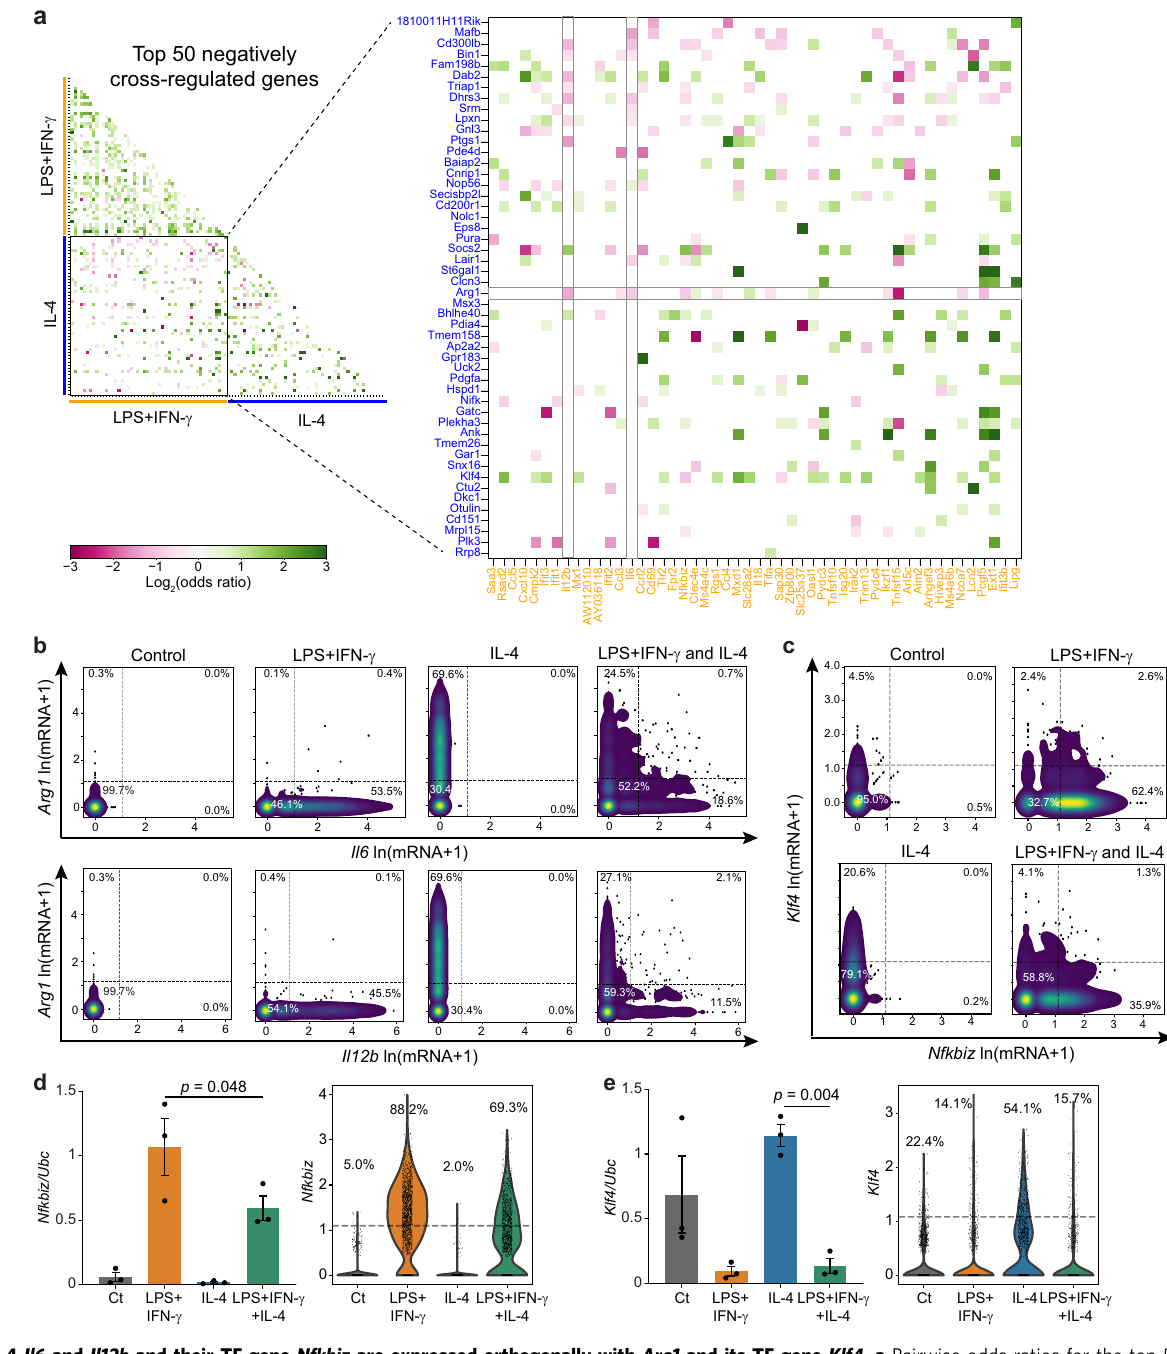
Fig. 4 Il6 and Il12b and their TF gene Nfkbiz are expressed orthogonally with Arg1 and its TF gene Klf4 . a Pairwise odds ratios for the top 50 downregulated genes in the LPS + IFN- γ (yellow) and IL-4 (blue) core gene programs measured in co-stimulated cells. Data are presented as the log2(odds ratio). The color bar indicates the strength and magnitude of the association. Odds ratios with a p -value > 0.05 (determined by two-sided Fisher ’ s exact test) are set to 0. b , c Density scatter plots of scRNA-seq transcript counts across individual cells for Arg1 vs. Il6 ( b ; top) and Il12b ( b ; bottom) and Klf4 vs. Nfkbiz ( c ). Data are represented as ln(transcript count + 1). d , e Population RT-qPCR measurements (left) and violin plots of scRNA-seq measurements (right) of Nfkbiz ( d ) and Klf4 ( e ) after stimulation for 6 h with media alone, LPS + IFN- γ , IL-4, or both. Population mRNA levels are presented relative to those of the control gene Ubc (mean ± SEM, n = 3 biological replicates). Two-sided one-way ANOVA with Sidak correction for multiple comparisons. Single-cell data is presented as the ln(transcript count + 1) from a single experiment. Source data are provided as a Source Data fi le. After 48 h of co-stimulation, we observed orthogonal secretion was not observed between CCL5 and Chi3l3 or TNF and Chi3l3 of IL-6 and IL-12p40 and the IL-4-induced marker Chi3l3 (Supplementary Fig. 5a), consistent with the scRNA-seq results (Fig. 5a), similar to what we observed at the transcript level at 6 h. (Supplementary Fig. 5b). To verify orthogonal secretion, we Indeed, we found very few cells that co-secreted IL-6 and Chi3l3 calculated the odds ratio between all pairwise combinations of or IL-12p40 and Chi3l3 (Fig. 5b, green). This orthogonal behavior secreted proteins in co-stimulated cells to measure whether the NATURE COMMUNICATIONS| (2021) 12:301